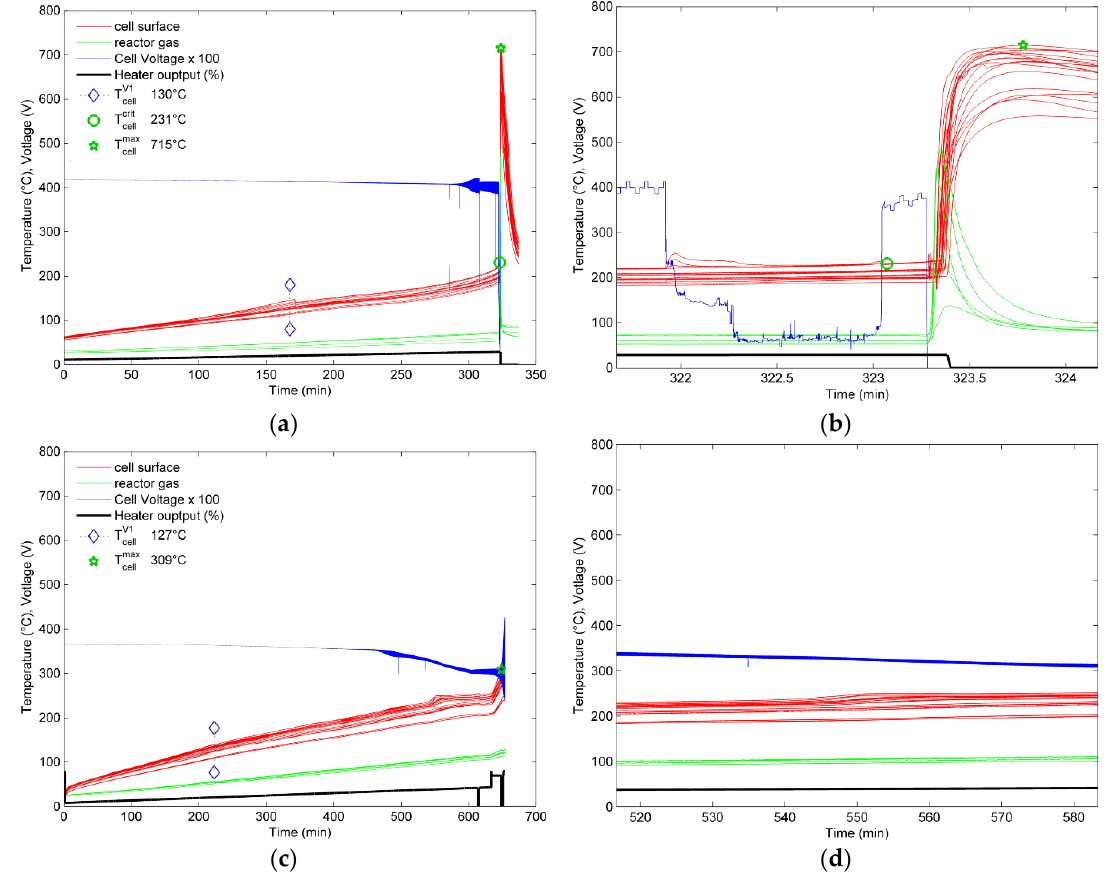
Figure 6. Overtemperature experiments of a fresh automotive pouch cell at ( a , b ) 100% SOC and ( c , d ) 30% SOC: ( a , c ) show the temperatures at up to 30 di ff erent positions during the heat ramp experiment measured on the cell surface (red) and inside the reactor (green). The heater output of the sample holder in% is plotted (black line). The cell voltage times 100 is plotted in blue. ( b , d ) show the temperature measured at the main exothermic event. In ( b ) ± 1 A pulses are visible